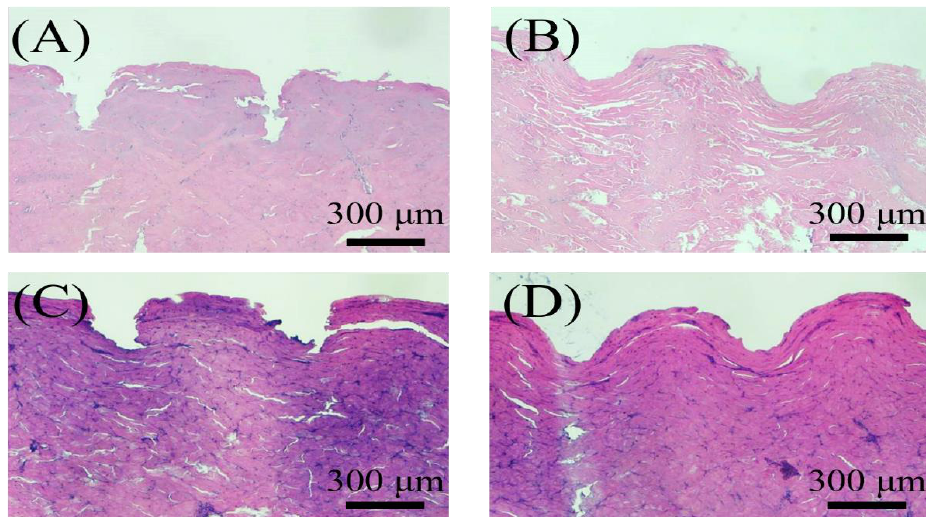
Figure 5. Images of H&E-stained skin sections after the application of ( A ) pure Gel, ( B ) GA-loaded, ( C ) QAGN-loaded, and ( D ) GA + QAGN-loaded MNs.